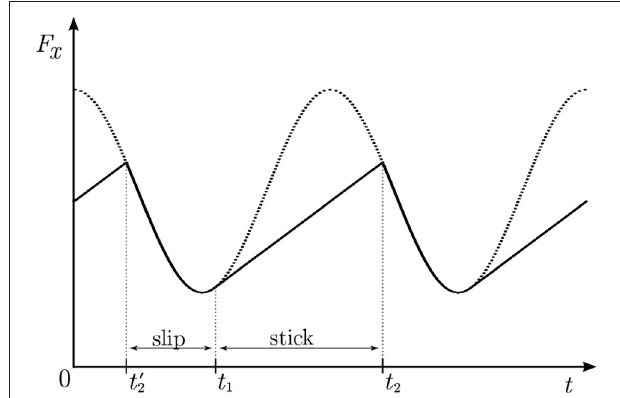
FIGURE 3 | Stick and slip under the influence of a harmonic oscillation. The dotted line represents the tangential force as it would be in pure slip [ F slip = µ 0 F z ( t )]. The solid line is the actual tangential force in the presence of stick-slip. The stick phases are the straight segments, e.g., between t 1 and t 2 , while slip phases are the sinusoidal segments, e.g., between t ′ 2 and t 1 , repeating periodically. Note that F x ≤ F slip everywhere, which is the origin of friction reduction in our